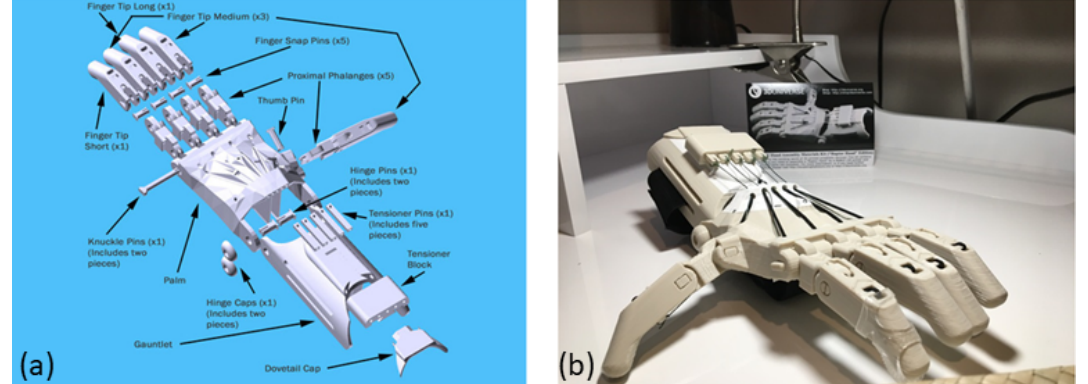
Figure 2. The Raptor reloaded hand by Enable available for download via Thingiverse. ( a ) Exploded view of design and user assembly methods. ( b ) Completed assembly of device. https://www.